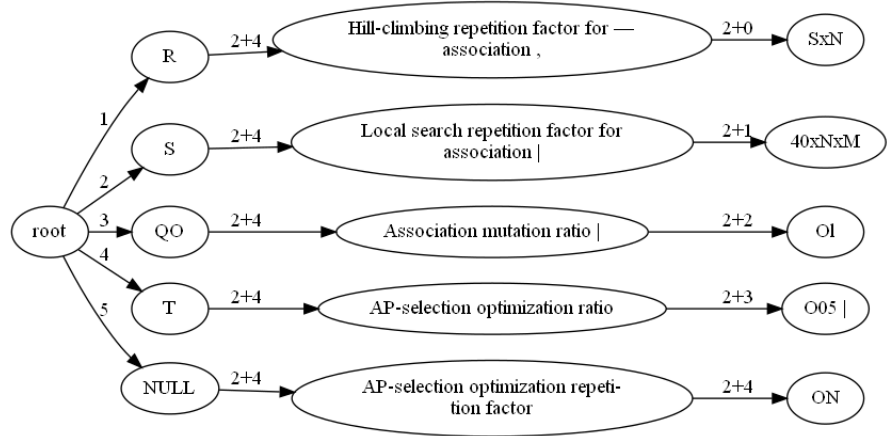
Figure 26. Tree for scanned table image